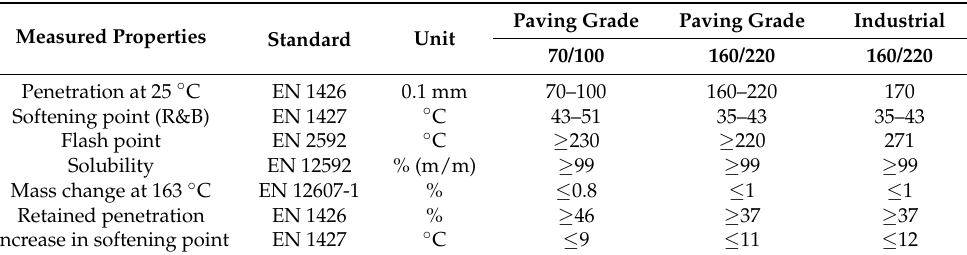
Table 1. Fundamental physical properties of bitumens.